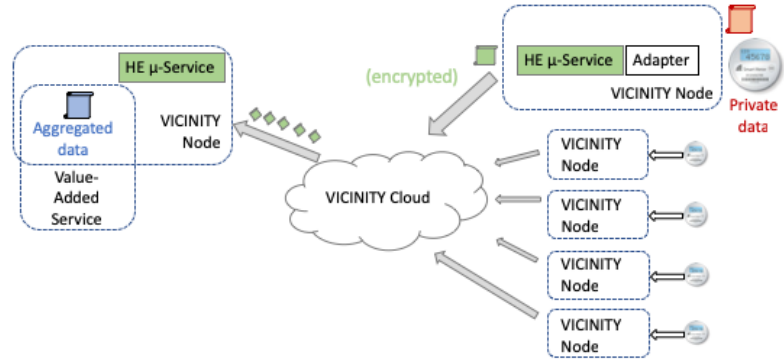
Figure 9. Homomorphic encryption micro-service applied to use